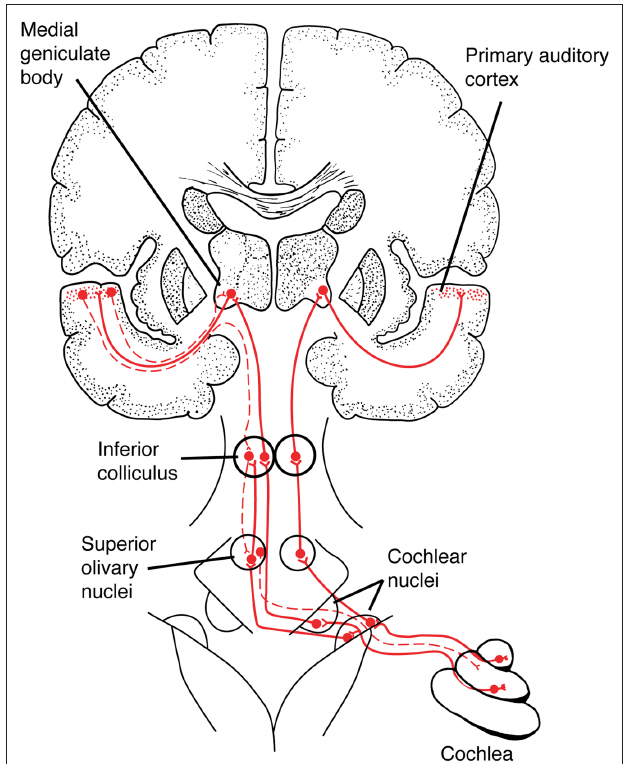
FiguRE 1 | A simplified schematic of the ascending auditory pathway between the cochlea and primary auditory cortex, showing a few of the subcortical structures involved in auditory processing, such as the cochlear nuclei in the brainstem and the inferior colliculus in the midbrain. Solid red lines show ascending auditory pathways, dashed lines show descending (“corticofugal”) auditory pathways. (In this diagram, corticofugal pathways are only shown on one side of the brain for simplicity. See Figure 2 for a more detailed network diagram). From Patel and Iversen (2007), reproduced